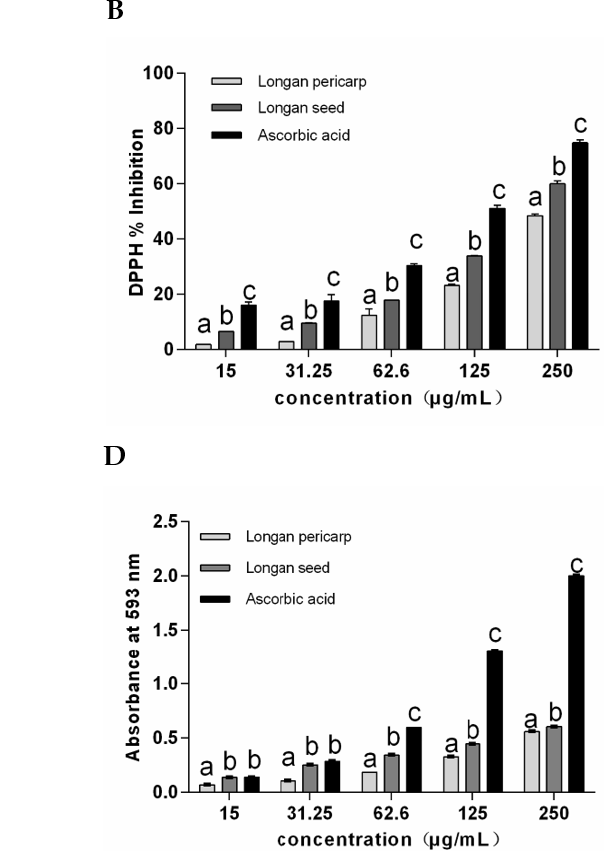
Figure 1. Antioxidant capacity of ECTs in longan pericarps and seeds: ( A ) DPPH values of FLP and FLS; ( B ) DPPH values of DLP and DLS; ( C ) FRAP values of FLP and FLS; ( D ) FRAP values of DLP and DLS. In the results, “a” represents the reference group, b represents significant differences with the “a” group (such as p < 0.05), c represents more significant differences with the “a” group (such as p < 0.01). Table 2. Antioxidant activities of longan